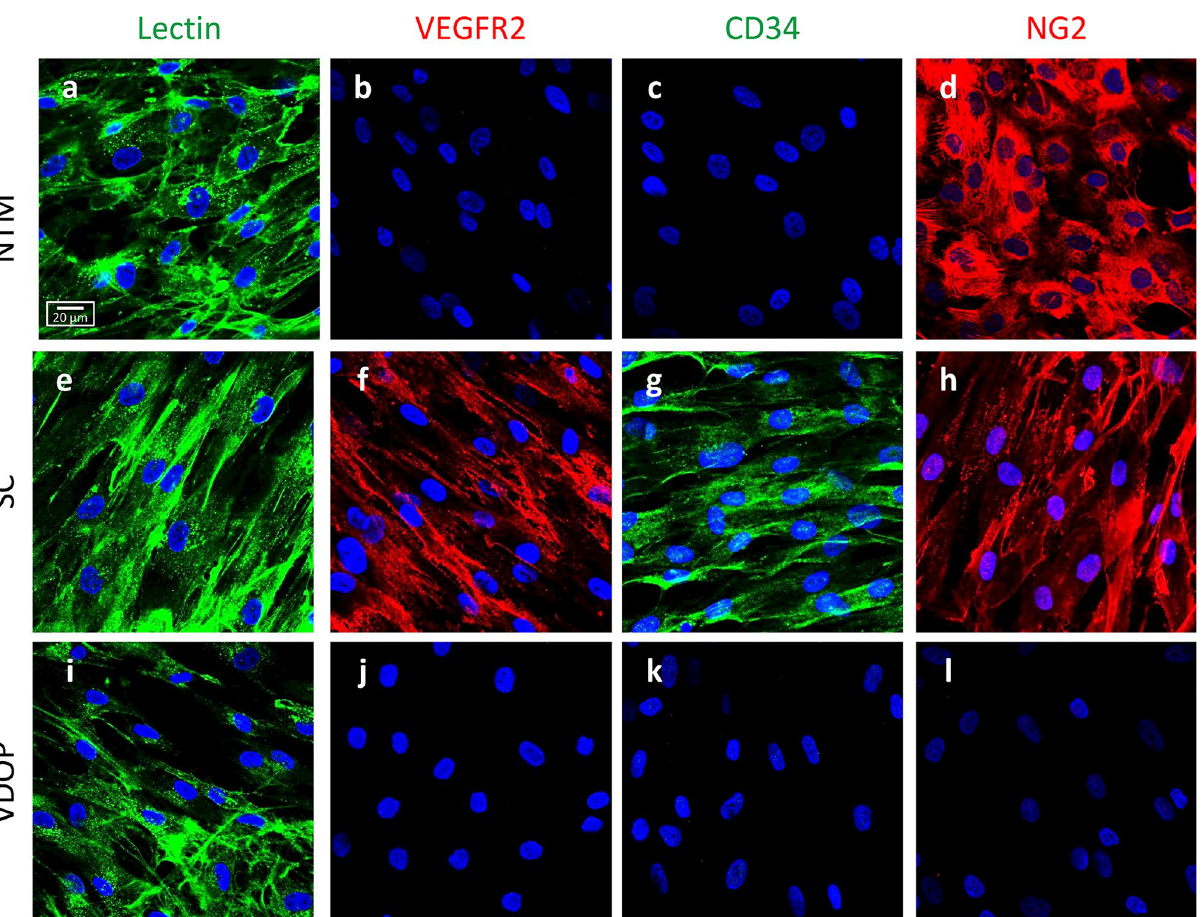
Figure 3. Phenotypic characterization of VDOP cells. Localization of various endothelial markers lectin, VEGFR2, CD34 and NG2 in NTM ( a – d ), SC ( e – h ) and VDOP ( i – l ) cells using immunohistochemistry. All three cell types were positive for Lectin ( a , e , i ) while VEGFR2 was seen only in SC and VDOP cells ( f , j ). CD34 was found only in SC cells ( g ) whereas both NTM and SC cells stained positive for NG2 ( d , h ). Based on this staining pattern, NTM cells were defined as Lectin + VEGFR2 - CD34 - NG2 + , SC cells as Lectin + VEGFR2 + CD34 + NG2 + and VDOP cells as Lectin + VEGFR2 - CD34 - NG2 - .A total of 8 VDOP (6 at passage 4 and 2 at passage 5), 3 NTM (2 at passage 5, one at passage 6) and 3 SC (all at passage 6) cell lines were used for this experiment. Scale bar, 20